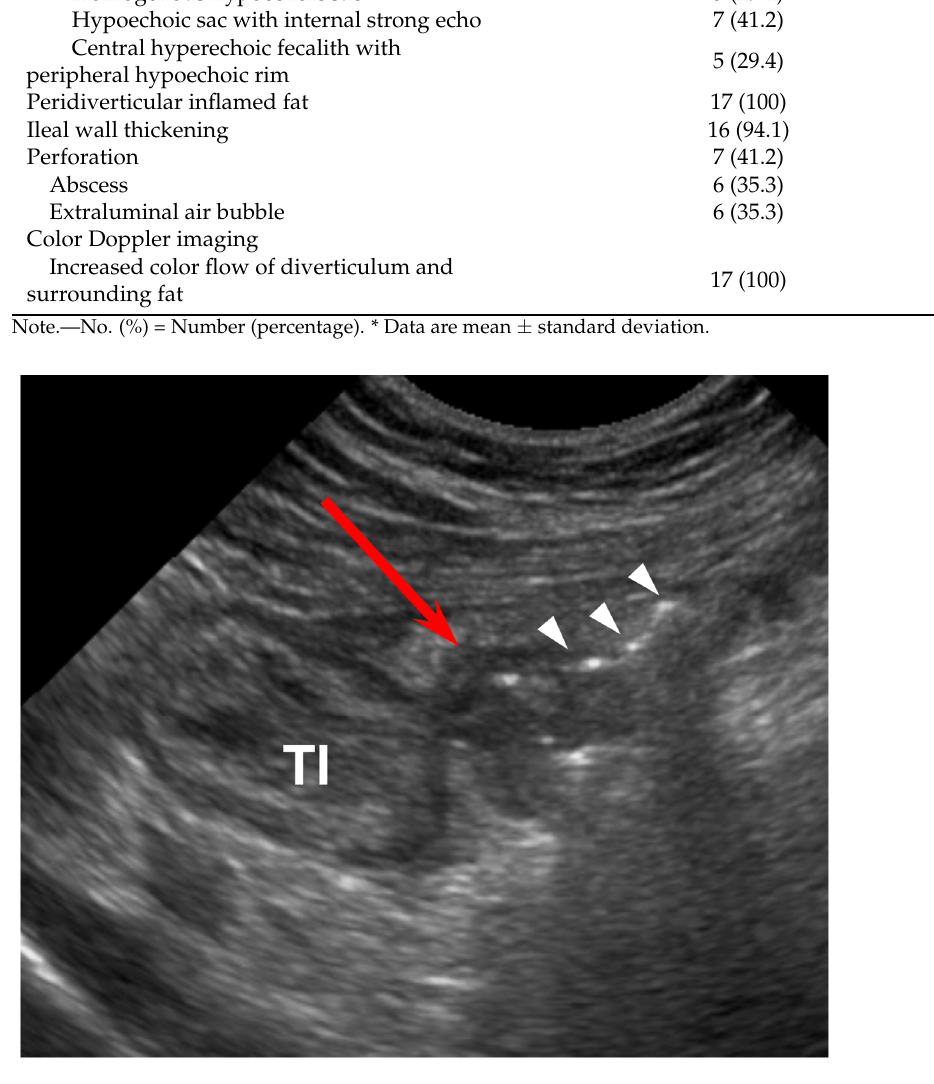
Figure 6. Forty-two-year-old male (patient #5) with acute perforated ileal diverticulitis. Axial US scan reveals ileal wall thickening (TI), an outpouching hypoechoic diverticular sac (red arrow) and linear reverberating strong echoes (arrowheads) in the mesentery, suggesting perforation.